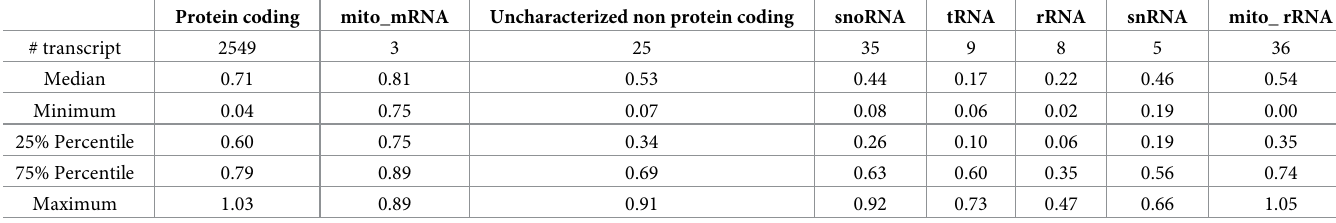
Table 2. Distribution of ‘divergence’ normalised by transcript length between base pairing determined by Structure-seq and in silico .